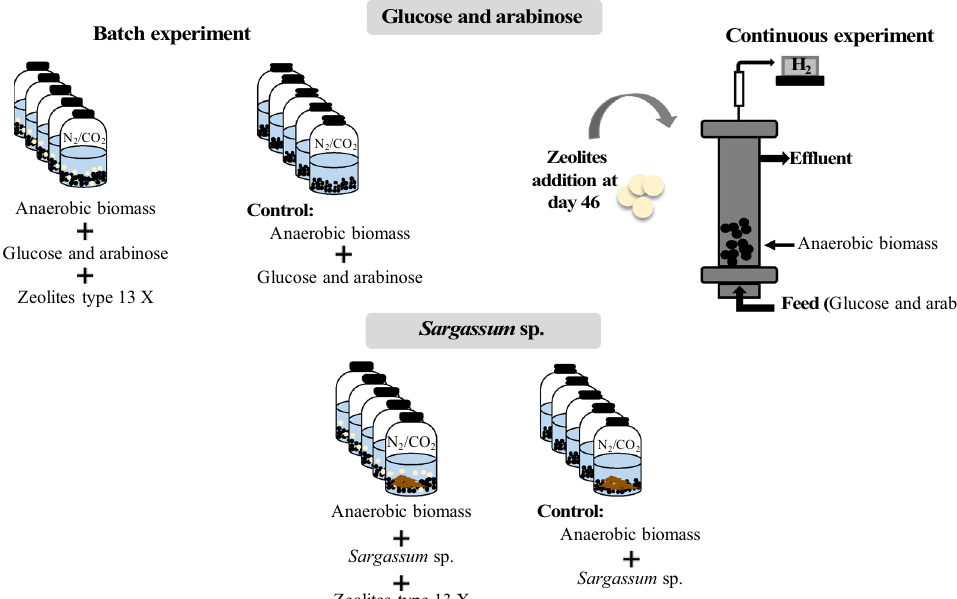
Figure 7. Schematic representation of the batch and continuous experiments for biohydrogen production by dark